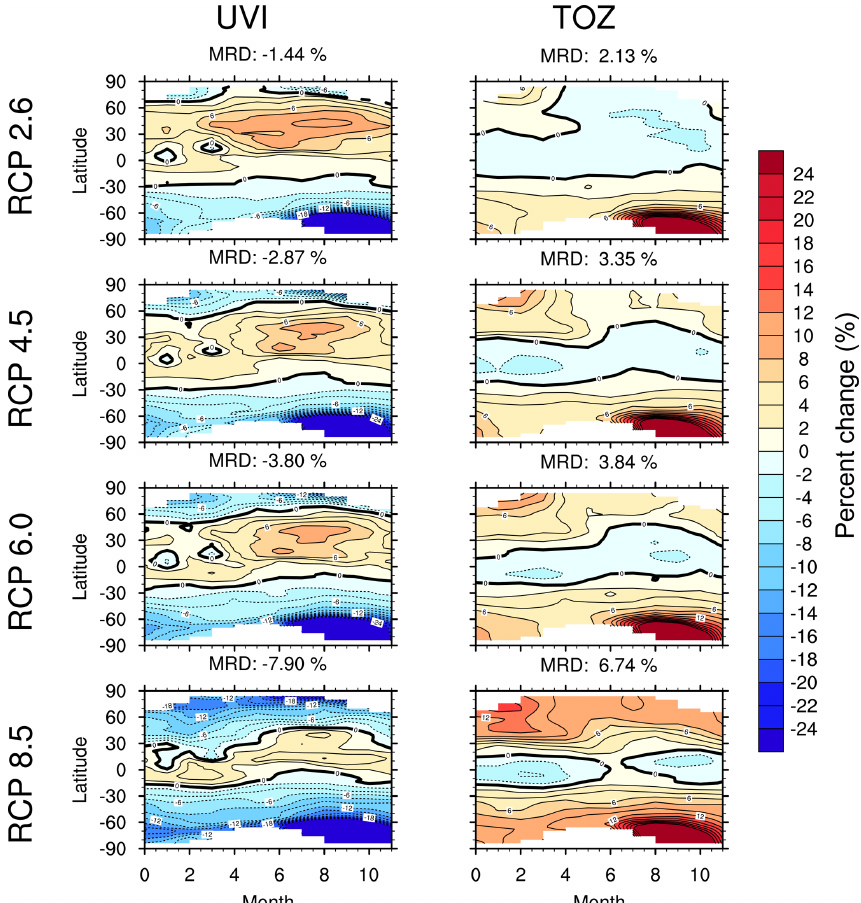
Figure 5. Latitudinal and monthly variation of UVI and TOZ percent change in 2090–2100 relative to 2000–2010 for the four RCP